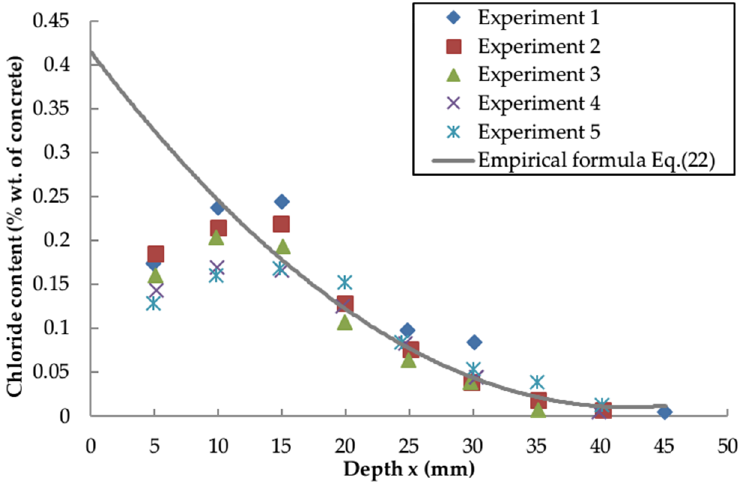
Figure 5. Comparison between experimental results and the results by presented formula (Equation (22)).